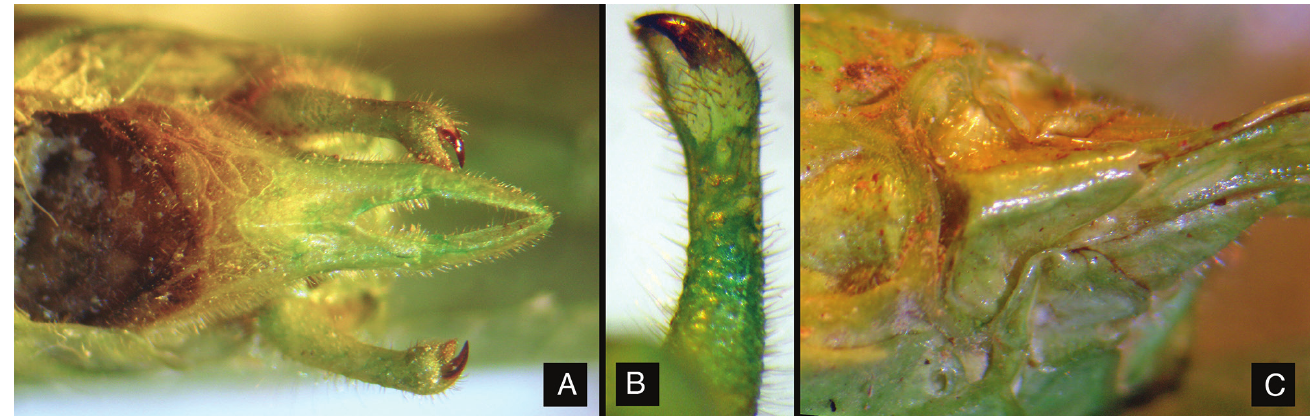
Fig. 4. Subgenital plate and cerci. A. Male subgenital plate and cerci, ventral; B. Male cercus, dorso-lateral view (dorsum to the left); C. Female subgenital plate with lateral sclerites, ventral